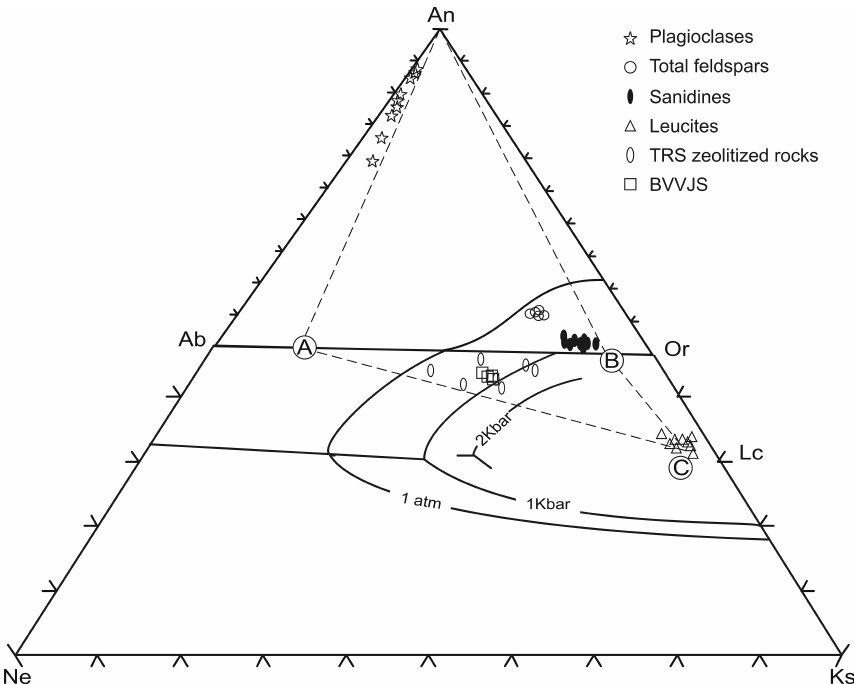
Figure 4. Projections of plagioclases, feldspars, total feldspars, leucites (symbols in figure) and of zeolitized rocks (full triangles) and BVVJS (empty squares) on the base of the phonolite pentahedron with ternary feldspar plane rotated into the plane NaAlSiO 4 -KalSiO 4 -SiO 2 . The boundary lines for Ph 2 O of 1atm is from Baldridge et al. (1981); those at 1 and 2Kbars are taken from Gittings (1979). The triangle ABC encloses compositions of TRS zeolitized rocks and of